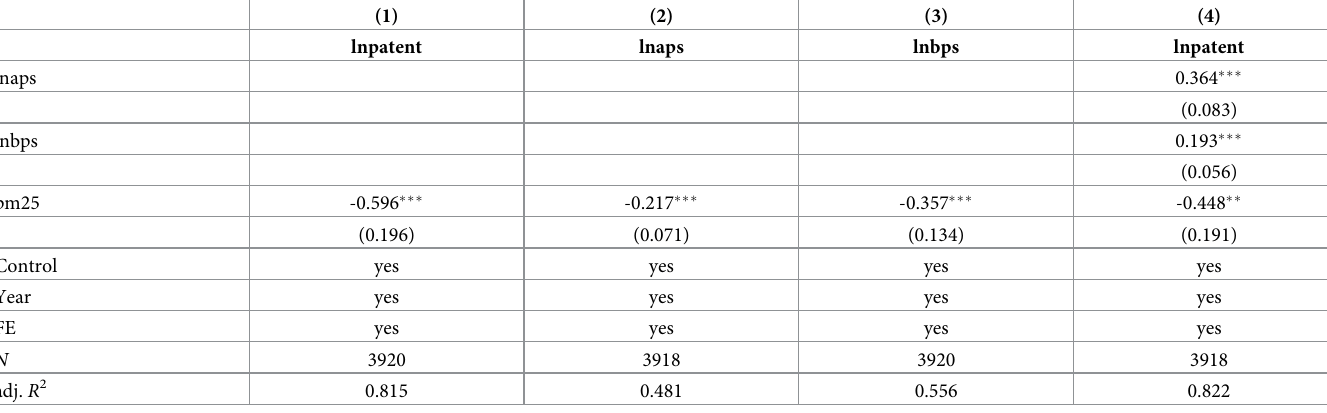
Table 14. Advanced productor services and basic productor